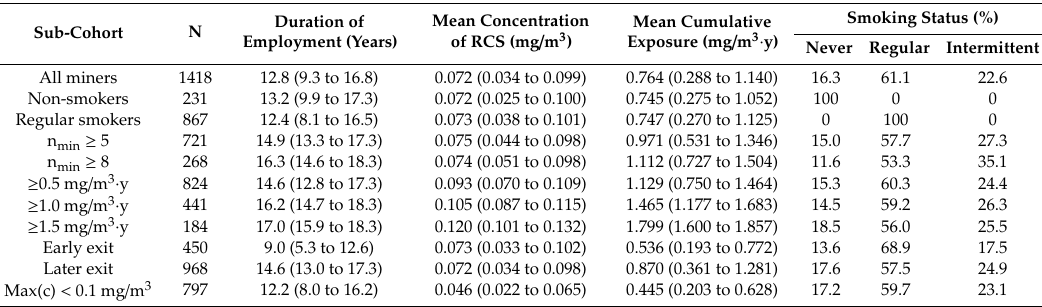
Table 2. Some characteristics of subgroups (means (interquartile ranges) or percentages). Mean Concentration Duration of Mean Cumulative Sub-Cohort N of RCS (mg / m 3 ) Employment (Years) Exposure (mg / m 3 · y) Never Regular Intermittent All